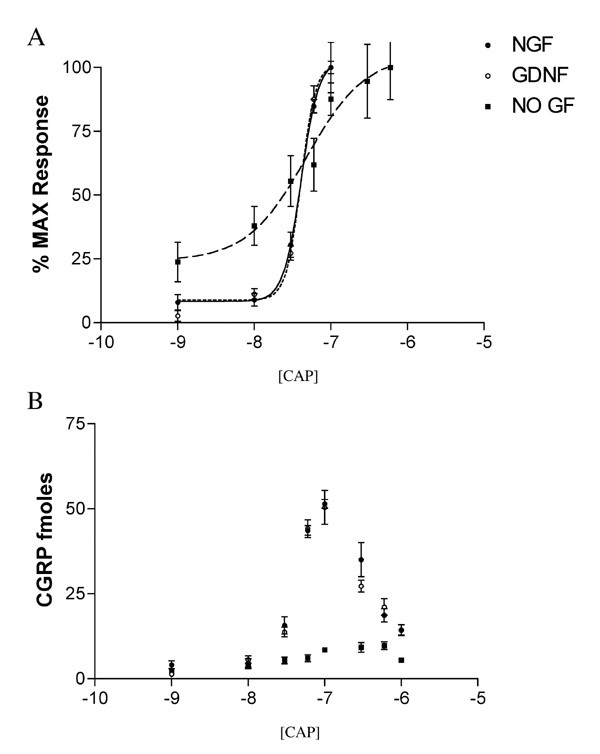
NGF and GDNF alter capsaicin-evoked CGRP release. Concentration-response functions (molar, log units) are shown for capsaicin-evoked CGRP release in TG cultures maintained in 100 ng/ml NGF, 100 ng/ml GNDF or no growth factor conditions (n = 6). Panel A illustrates the maximum relative effect of capsaicin under each condition matched to the maximum evoked-CGRP release for that given condition. Panel B depicts the CAP-evoked CGRP release data in terms of CGRP released in fmoles in the presence or absence of NGF or GDNF to illustrate the magnitude of increases in Emax and the biphasic nature of the capsaicin-evoked CGRP concentration-response function.